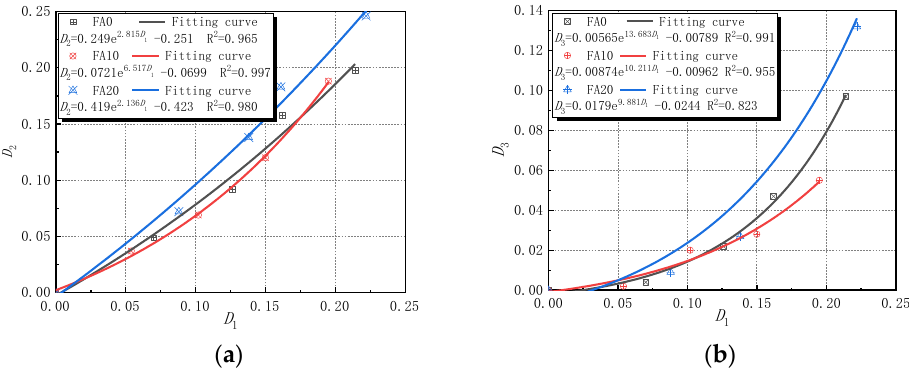
Figure 9. Relationship between different evaluation indexes of sulfate erosion damage. ( a ) Relationship between D 2 and D 1 and ( b ) relationship between D 3 and D 1 .